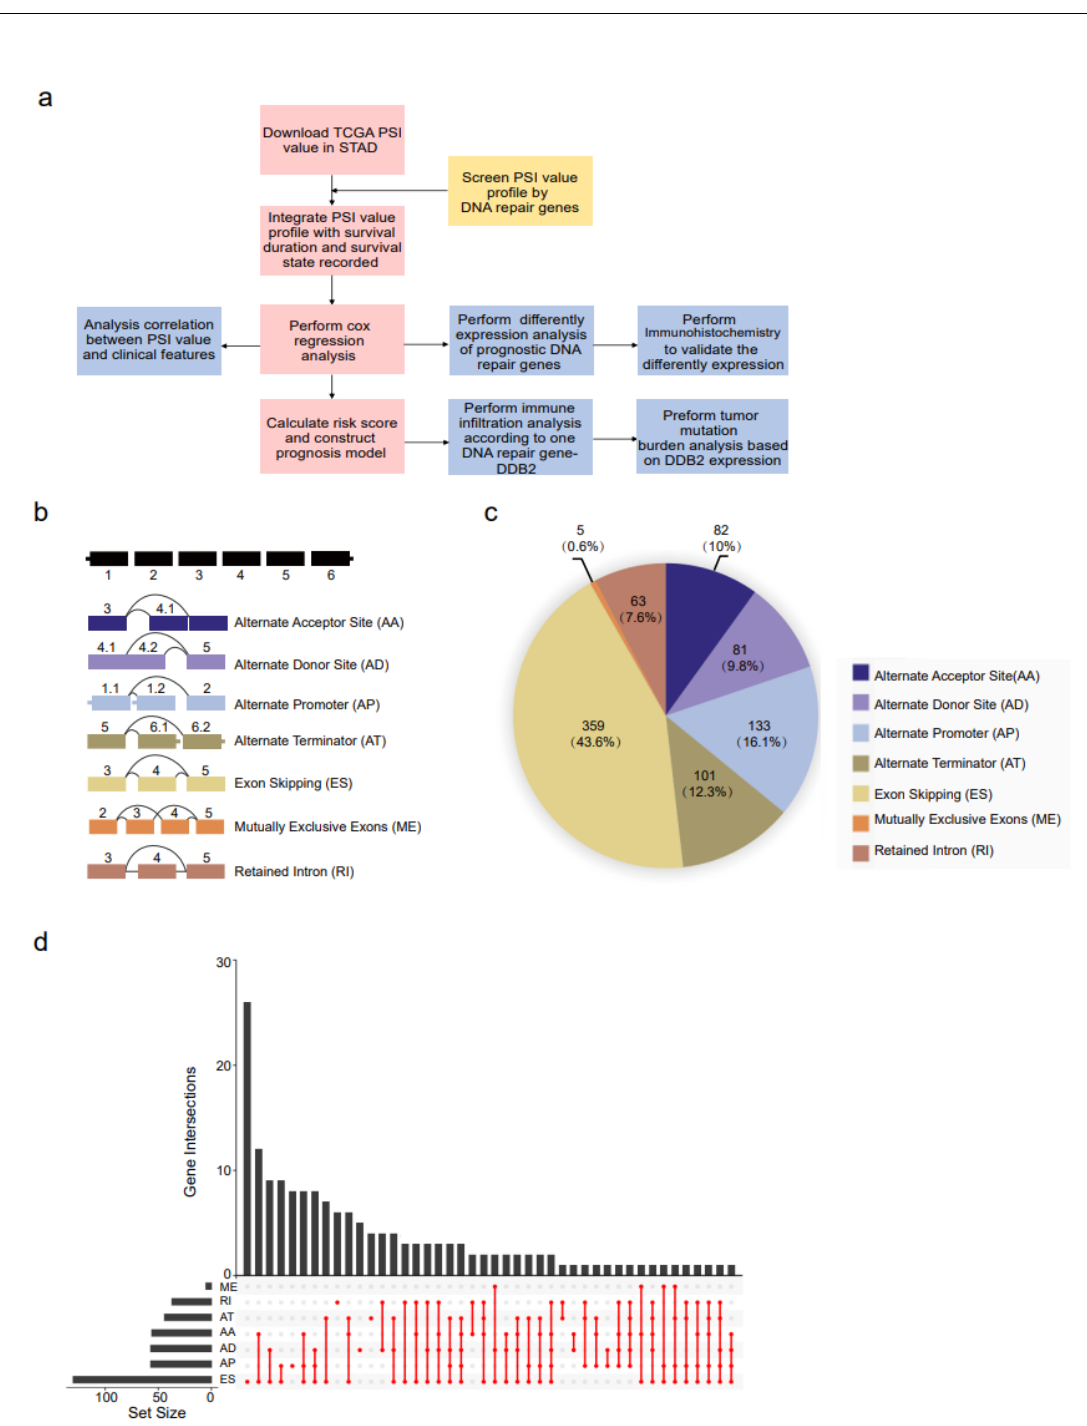
Figure 1. Overview of the dataset. ( a ) Flow chart of the research. ( b ) Illustration of the seven kinds of alternative splicing, namely AA, alternate acceptor site; AD, alternate donor; AP, alternate promoter; AT, alternate terminator; ES, exon skipping; ME, mutually exclusive exons; and RI, retained intron. ( c ) Number of AS events in 375 STAD patients. ( d ) UpSet plots of the seven types of optional splicing events and their parent genes.